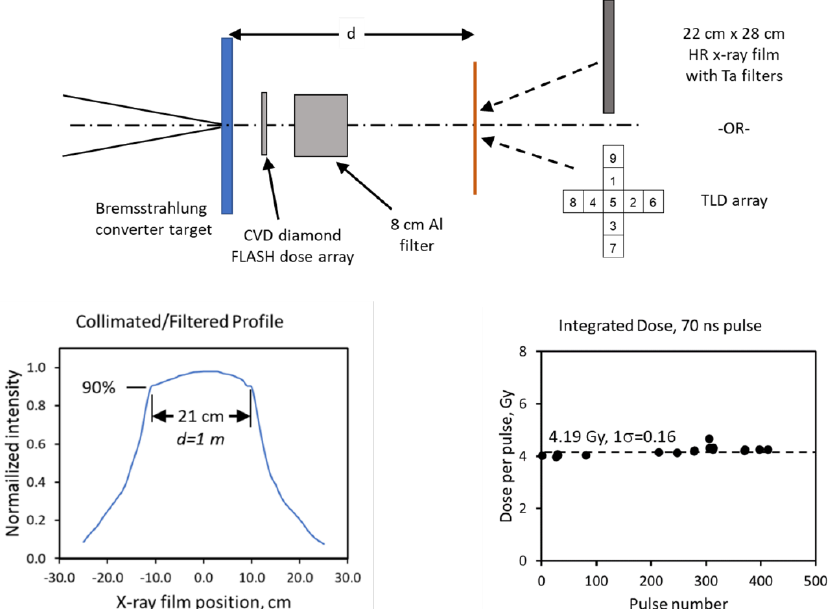
Figure 12. Measurement geometry, bremsstrahlung field flatness, and pulse-to-pulse repeatability [122]. (Sampayan, S.E.; et al., Sci. Rep. 2021, 11, 17104, https://doi.org/10.3389/fonc.2019.01563, reproduced with permission under the terms of the Creative Commons Attribution License (CC BY), http://creativecommons.org/licenses/by/4.0/).